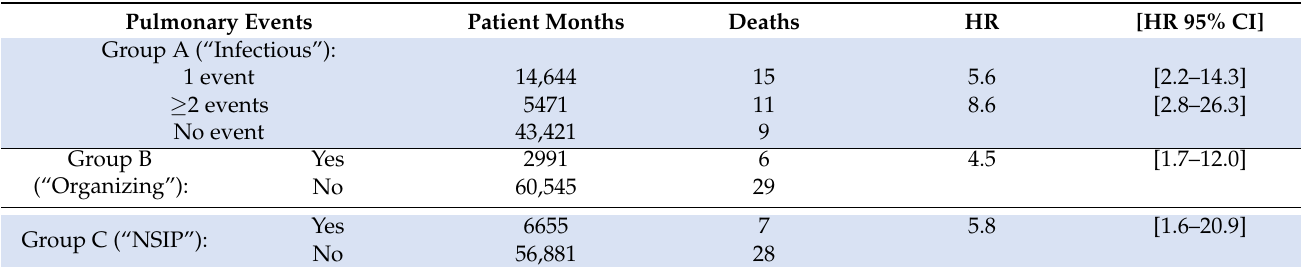
Table 2. Comparison of predictive effects of the three main groups of pulmonary events (Infectious, SOP, NSIP) on survival, according to a multivariate time-dependent Cox